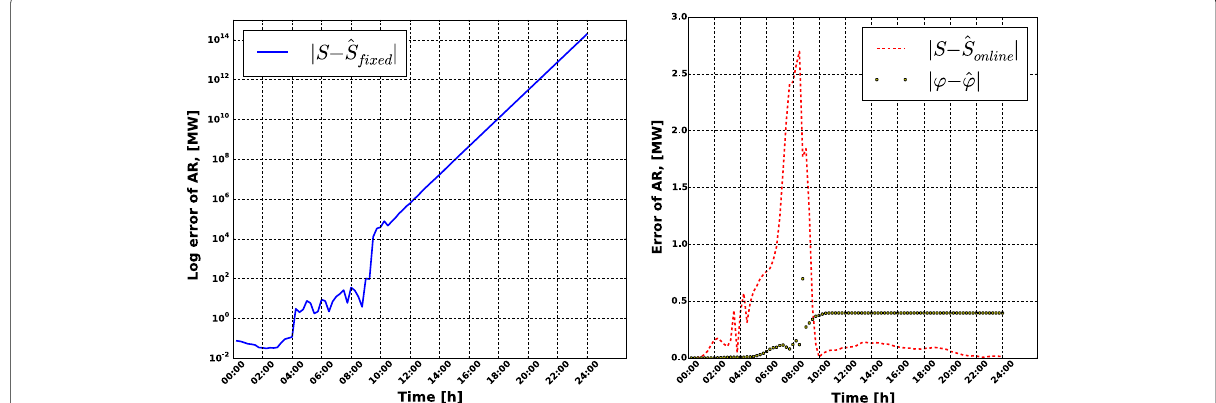
Fig. 7 Error between estimated and true values of active power at bus 6 for ϕ = [1.7, − 0.3]. Left figure shows the error for the fixed parameters model, whereas in the right one the red dashed line corresponds to the results for online learning technique and yellow dots show the error of